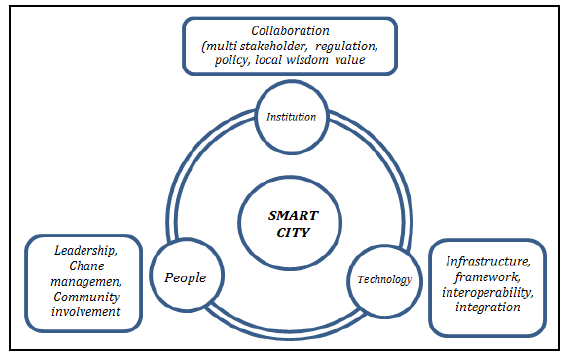
Figure 2. Three Pillars Smart City Implementation Model, adapted from Anindra